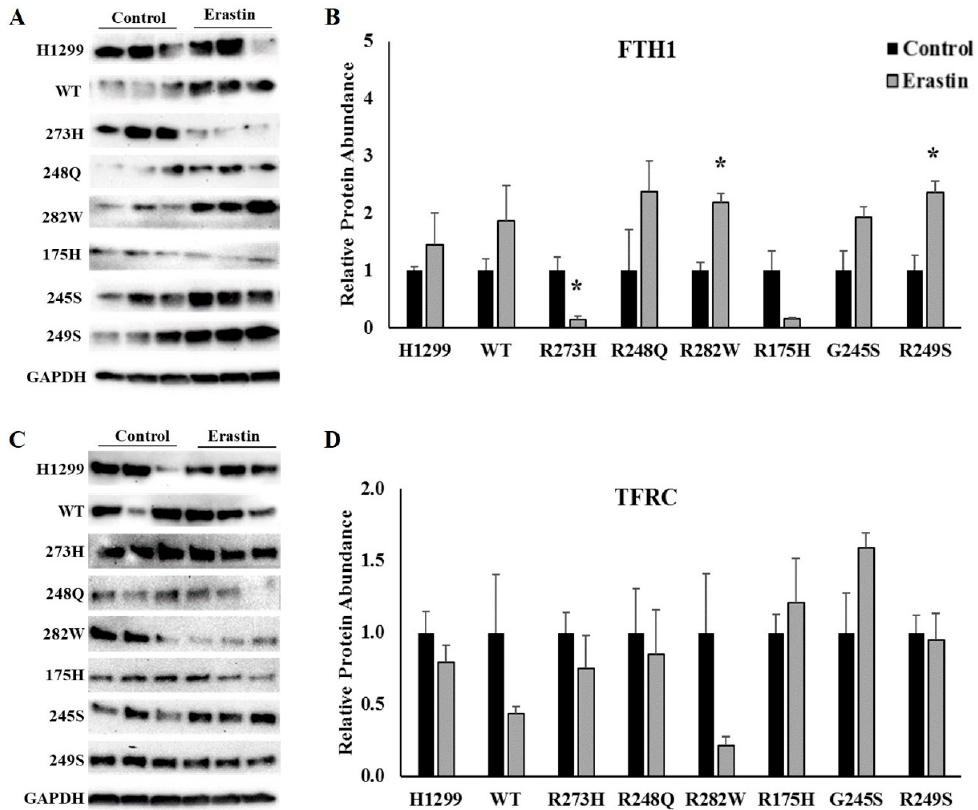
Figure 4. Erastin treatment differentially affects TFRC and ferritin heavy chain 1 (FTH1) protein expression in cells expressing distinct TP53 mutation types. Representative images and quantification of Western blots examining the expression of ( A , B ) transferrin receptor 1 (TFRC) and ( C , D ) ferritin heavy chain 1 (FTH1) in TP53 null H1299 cells (H1299) or H1299 cells transfected with wild-type (WT) TP53, or the indicated TP53 mutant following treatment with DMSO (control) or 10 µM erastin for 24 h ( n = 3-4 per cell type and treatment). Relative expression was normalized using glyceraldehyde 3-phosphate dehydrogenase (GAPDH) as a loading control. * Denotes statistical di ff erences from respective control, p < 0.05. Error bars indicate SEM.